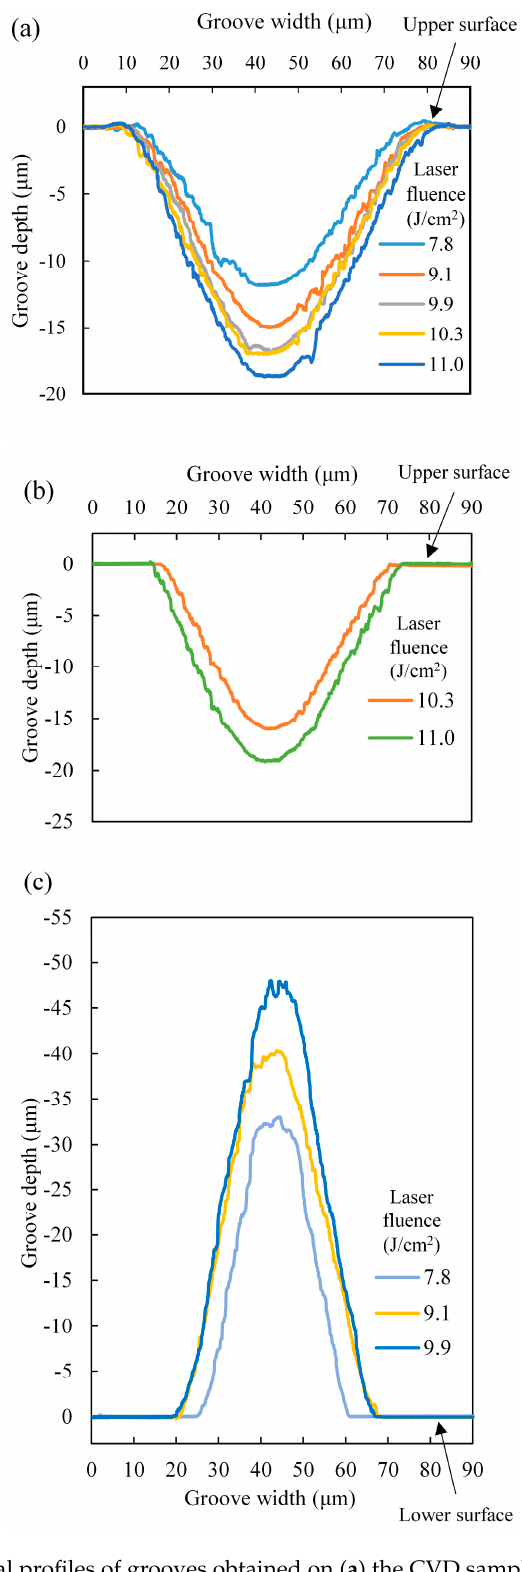
Figure 5. Cross-sectional profiles of grooves obtained on ( a ) the CVD sample; ( b ) the upper surface and ( c ) the lower surface of the HPHT sample.